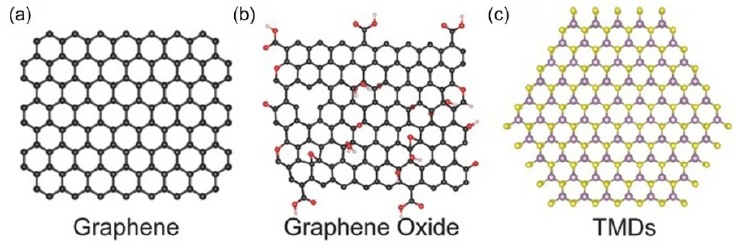
Figure 1. Schematic structures of ( a ) graphene, ( b ) graphene oxide, ( c ) transition metal dichalcogenides (TMDs), reprinted with permission from [23], Wiley, 2017.